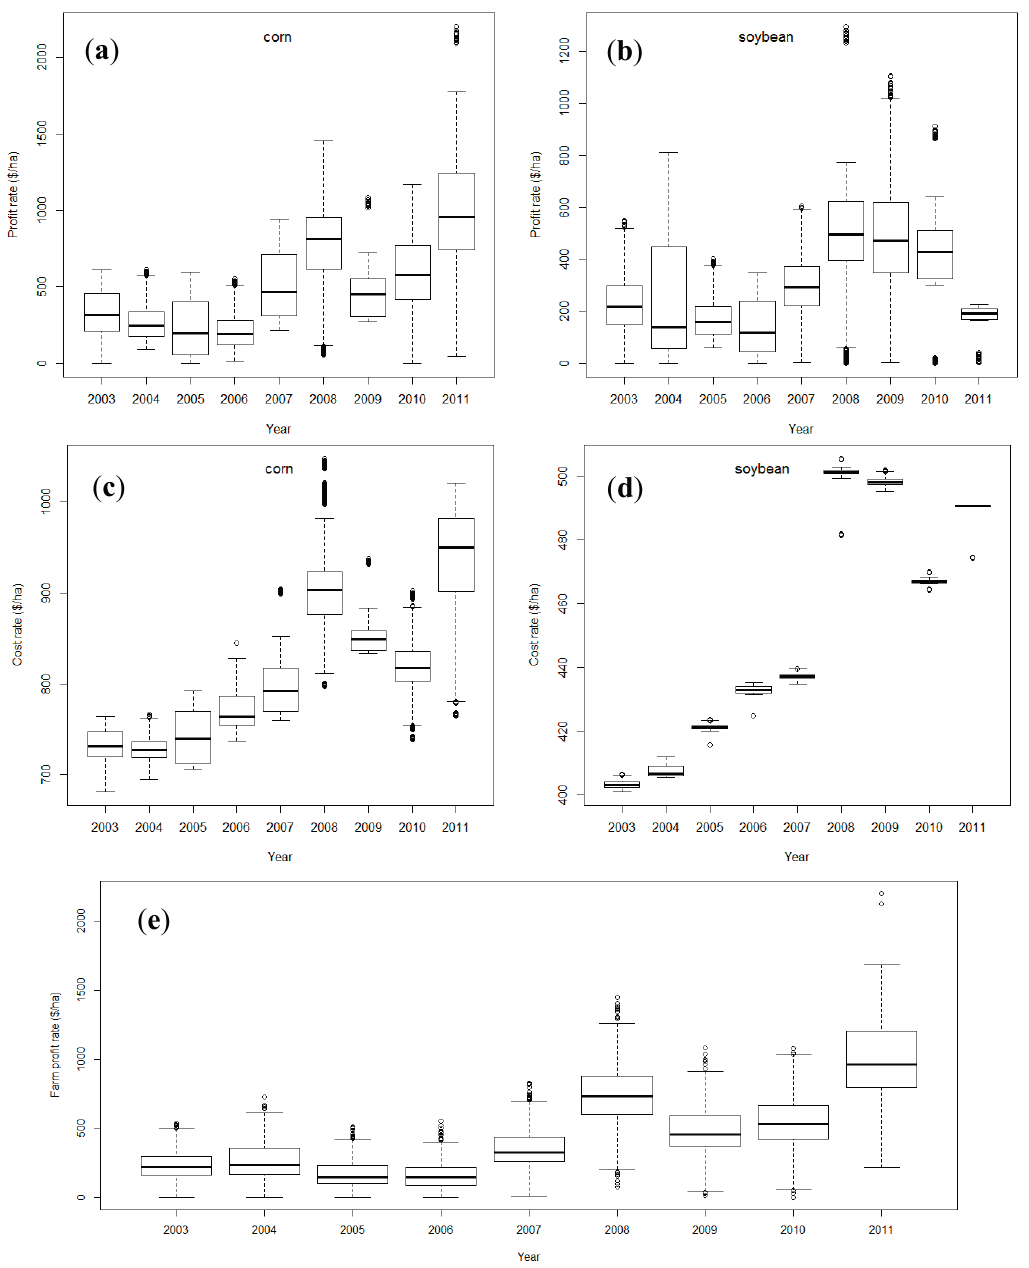
Figure 3. Box plots of simulated profit rate (( a ) corn; ( b ) soybean); and cost rate (( c ) corn; ( d ) soybean); and of farm-level profit rate ( e ).6.2. Model Results: Corn and Soybean Price Scenarios (Simulation Set